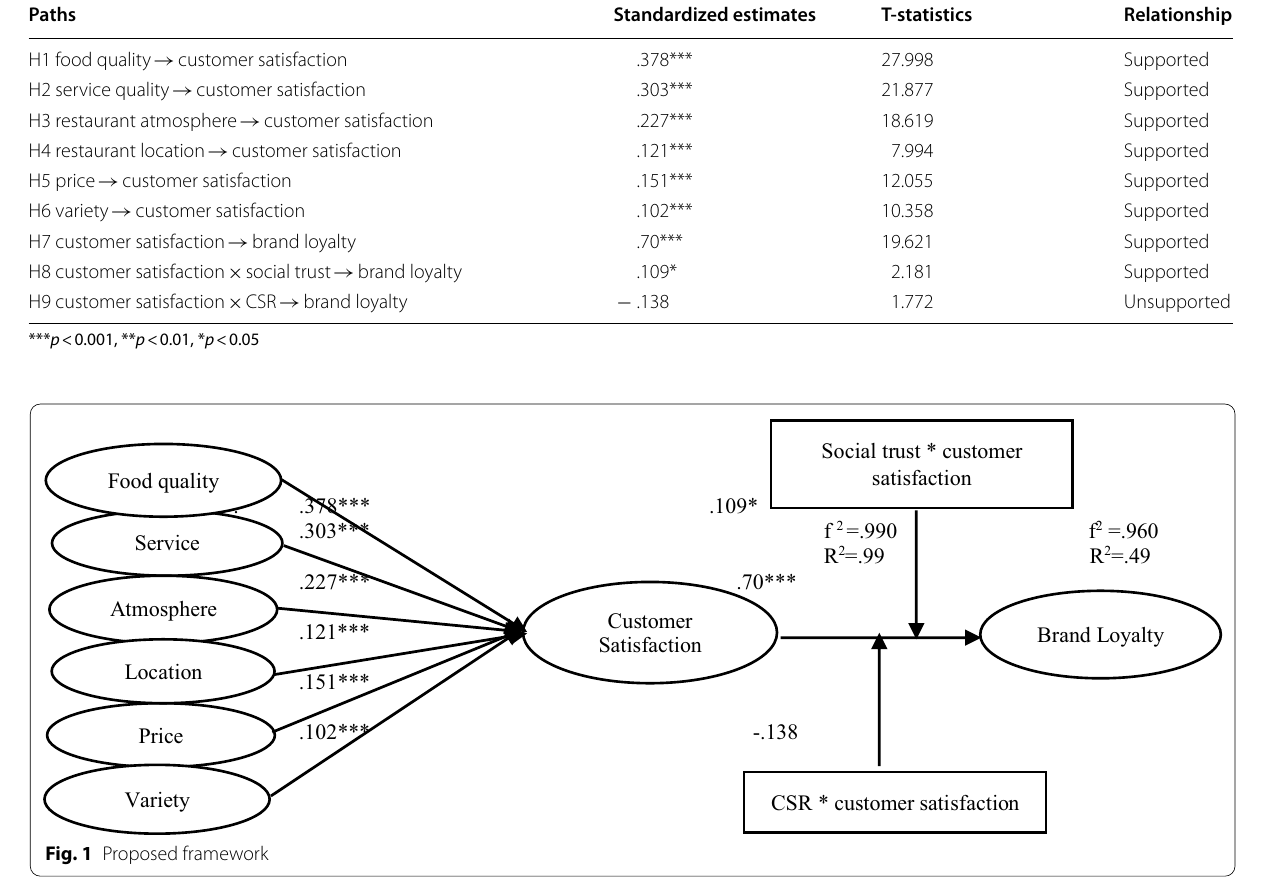
Table 4 Statistics of hypotheses testing